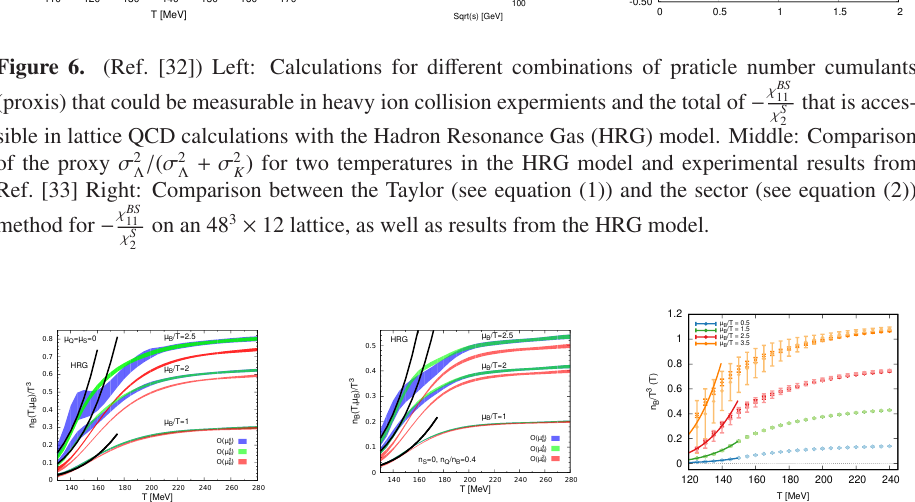
χ BS 11 that is acces- χ S 2 −